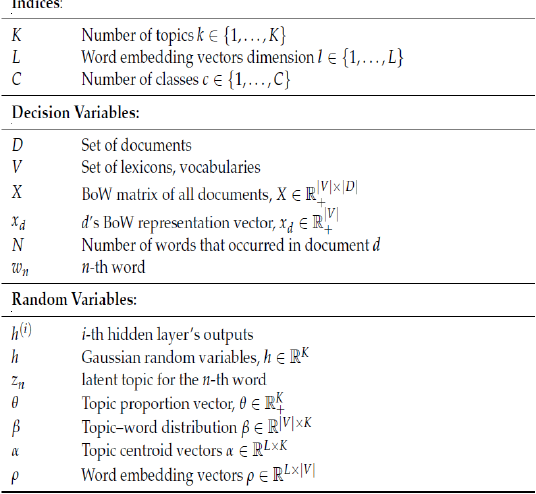
Table 1. List of used notations.